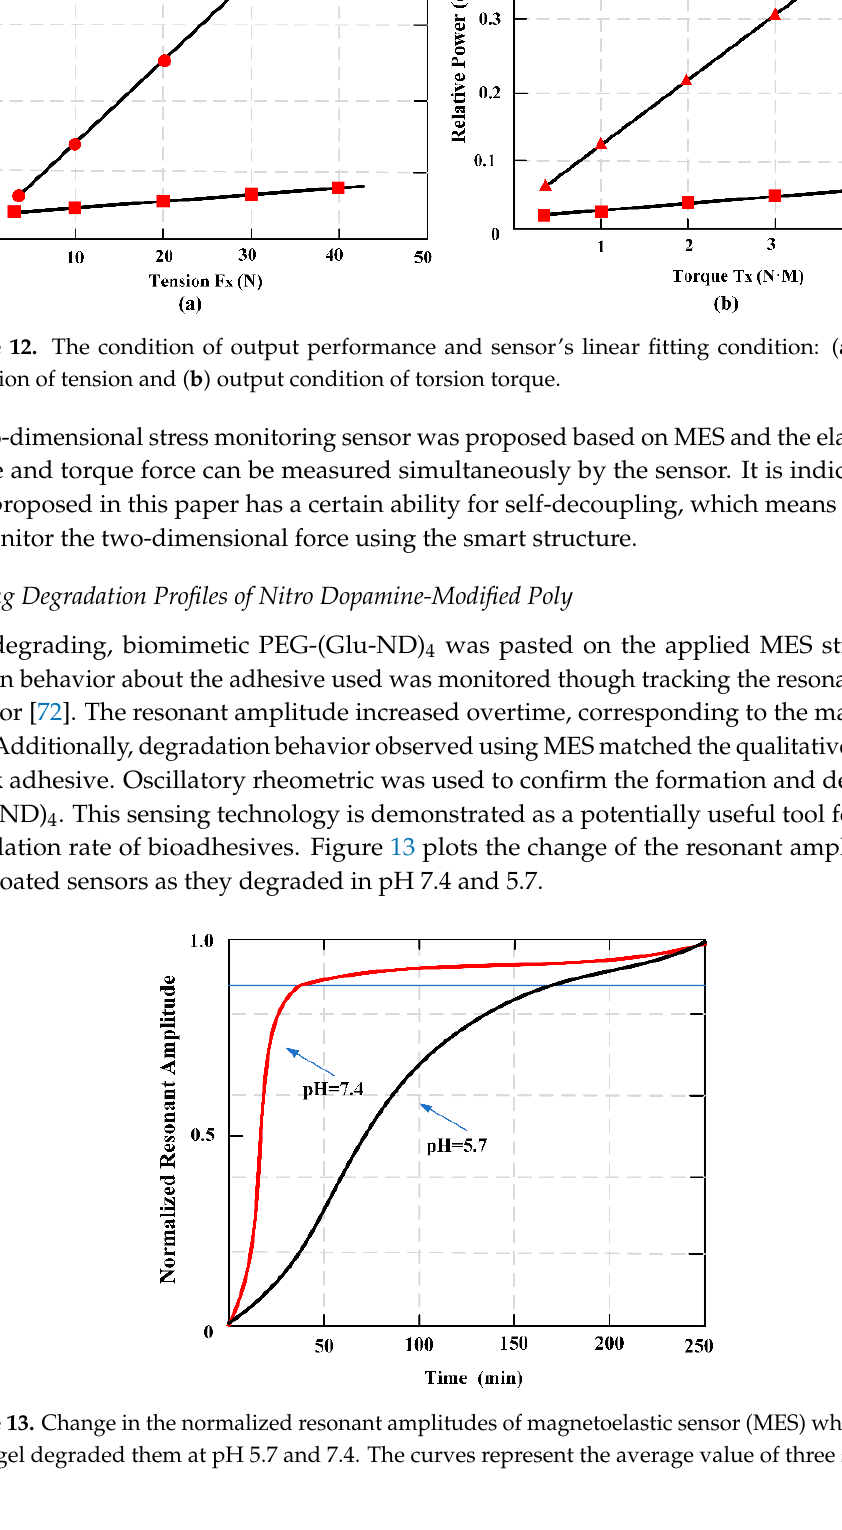
Figure 11. The 3D entity model structures of the designed sensor: ( a ) the elastomer structure model and ( b ) the pasted positions of the three MESs.